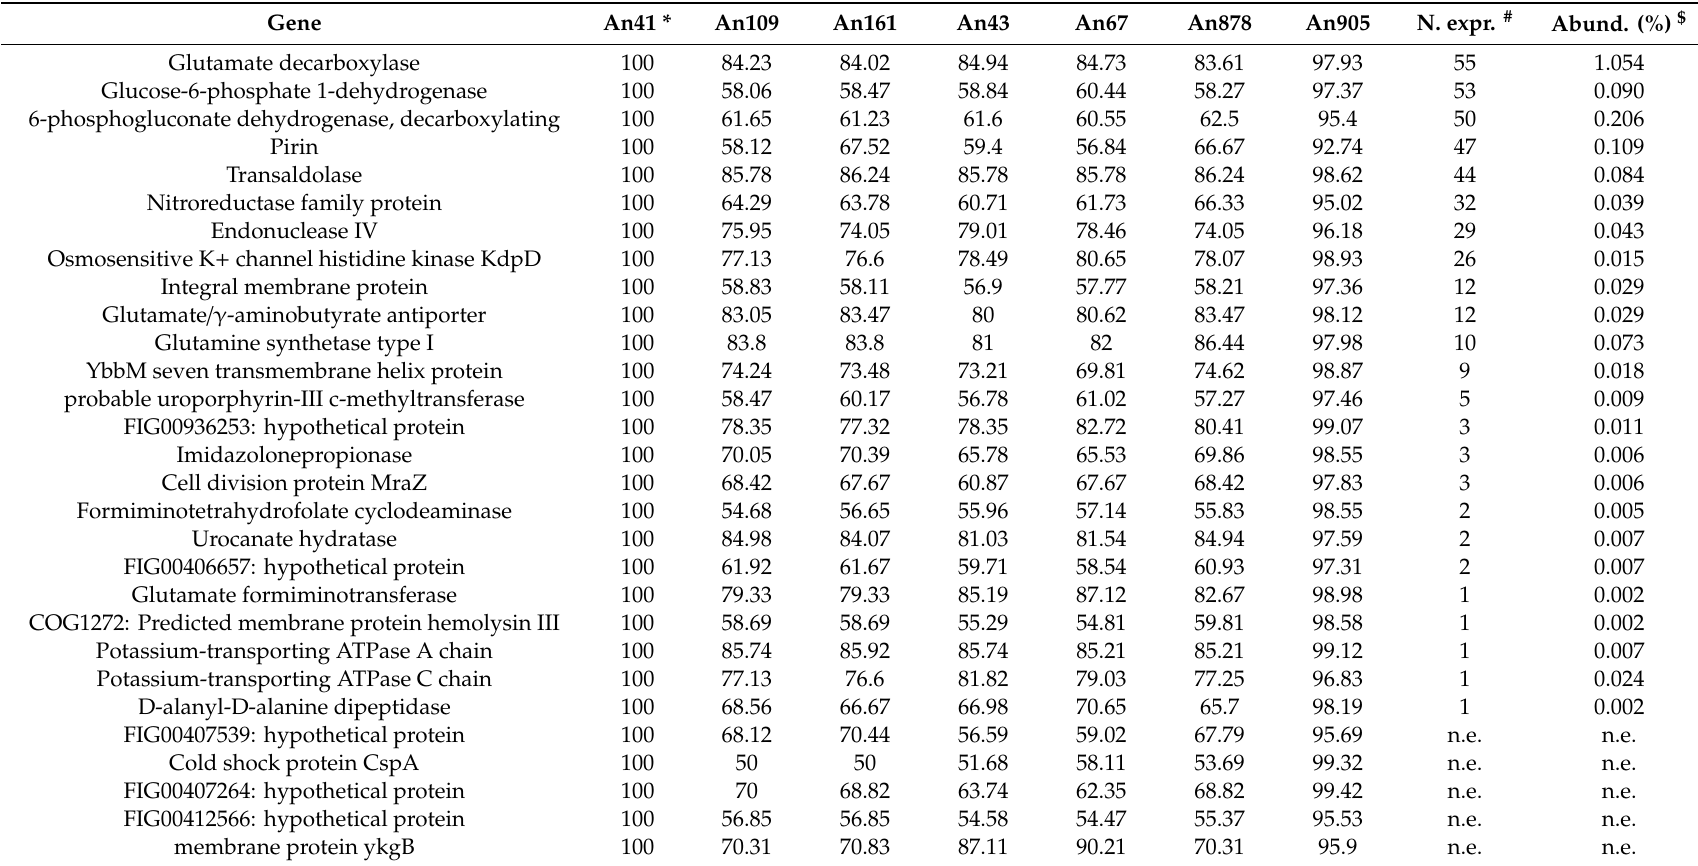
Table 1. Genes present in all human-adapted Bacteroides species but absent from chicken-adapted Bacteroides species.